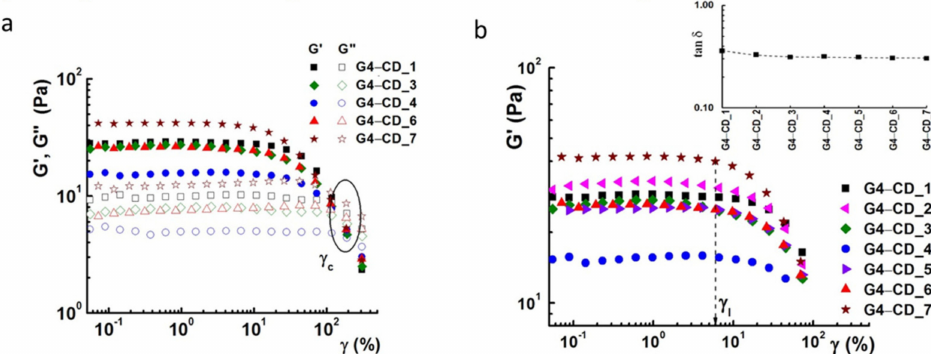
Figure 6. Variation of ( a ) the viscoelastic moduli and ( b ) G’ as a function of strain, γ , at 25 ◦ C and 10 rad s − 1 . The inset figure illustrates the evolution of tan δ at 1 Pa and 10 rad s − 1 for all samples.